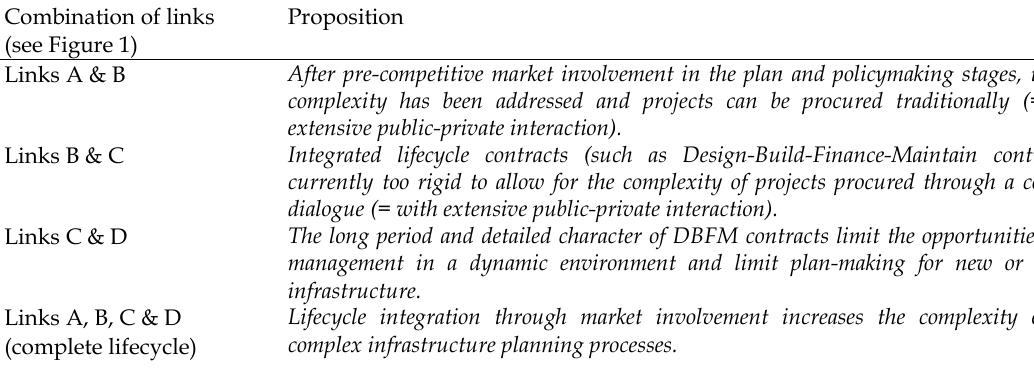
Table 2: Propositions and combination of